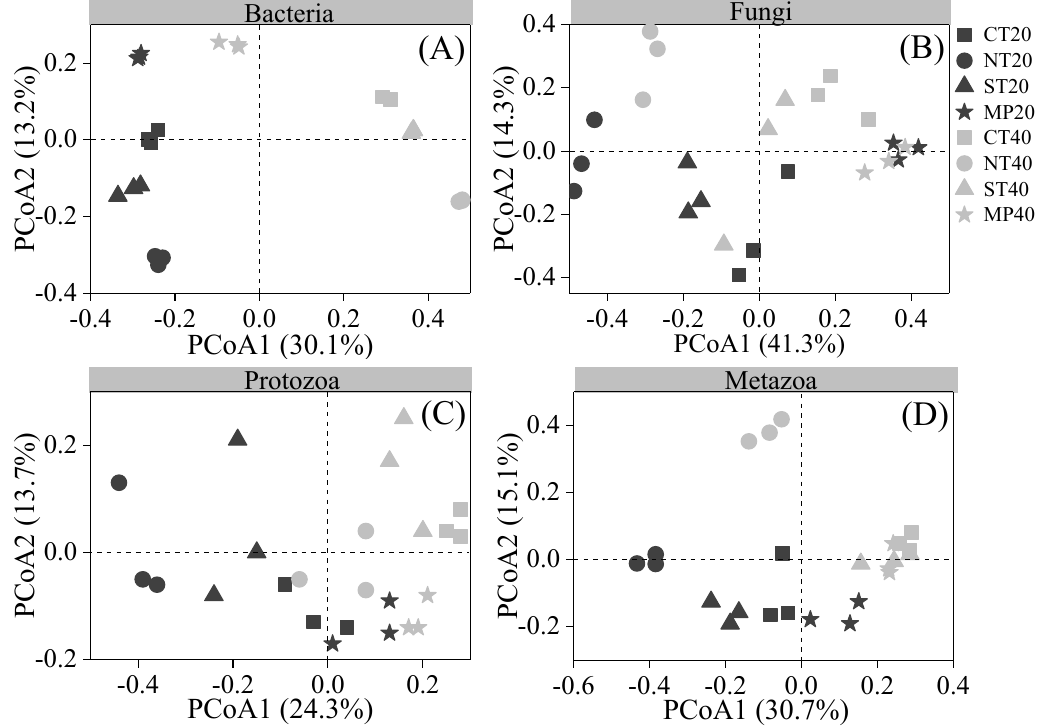
Figure 4. Principal coordinate analysis (PCoA) of changes in soil microbial (bacteria and fungi) and faunal (protozoa and metazoan) beta diversity. ( A ) Bacteria, ( B ) Fungi, ( C ) Protozoa, and ( D ) Metazoa. CT20, Rotary and ridge tillage at 0–20 cm depth; NT20, No-tillage at 0–20 cm depth; ST20, Subsoil tillage at 0–20 cm depth; MP20, Moldboard plowing tillage at 0–20 cm depth; CT40, Rotary and ridge tillage at 20–40 cm depth; NT40, No-tillage at 20–40 cm depth; ST40, Subsoil tillage at 20–40 cm depth; MP40, Moldboard plowing tillage at 20–40 cm depth. n = 24 (four treatments, three replications per treatment, and two soil